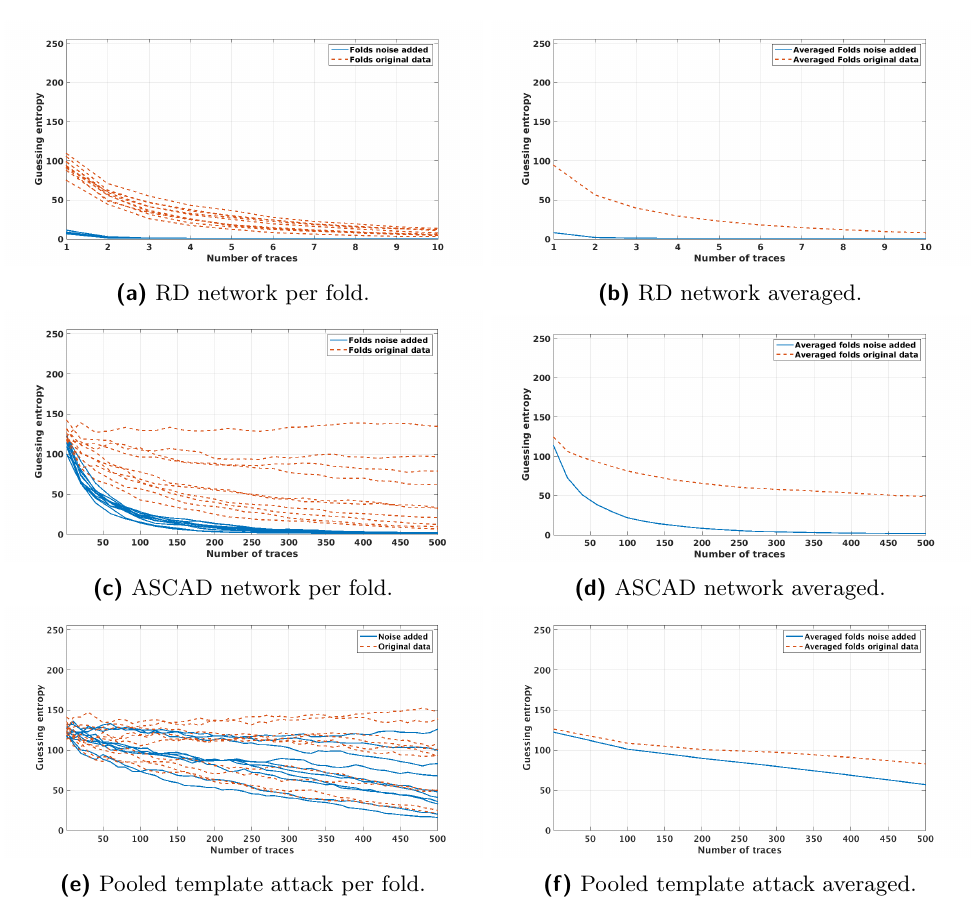
Figure 5: Guessing entropy results for the AES_RD